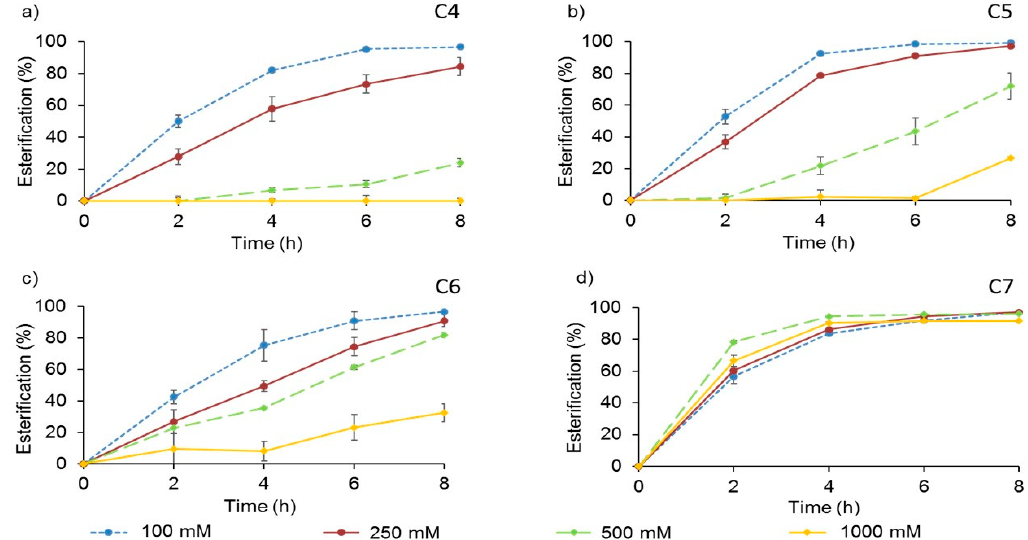
Figure 4. Effect of the substrates’ concentration in the esterification, catalyzed by AMNP-GA-OPEr, of 1-butanol and each VFA: ( a ) butanoic (C4); ( b ) pentanoic (C5); ( c ) hexanoic (C6); and ( d ) heptanoic (C7) acid. Reactions were performed in isooctane, at 25 °C and 100 rpm with an alcohol: acid 2:1 molar ratio and 11 U of the catalyst.